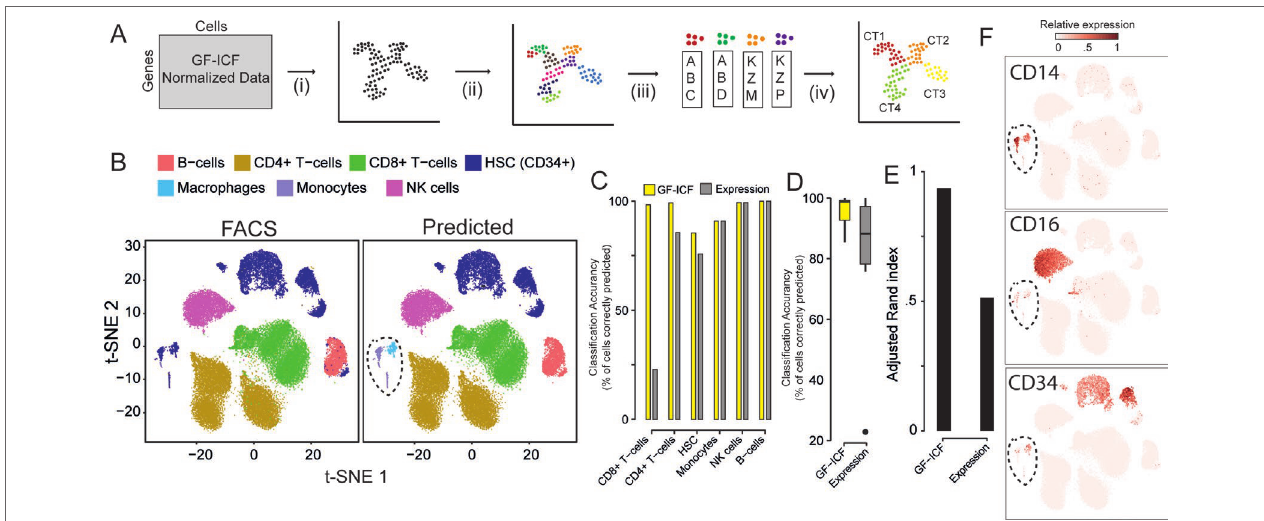
FIGURE 2 | Relevant genes extracted from the gf-icf pipeline enable cell type prediction. (A) Pipeline for the identification of cell type using gf-icf pipeline. Single-cell transcriptional profiles are normalized by gf-icf in order to score genes in each single-cell, and then (i) cells are projected with t-SNE in a bi-dimensional space; (ii) cells are divided in small groups using Louvain–Jaccard clustering; and (iii) the gene signature of each cluster is identified and (iv) used to predict cell type of origin by gene set enrichment analysis (GSEA) against a set bulk transcriptomic data of pure cell types. (B) Comparison between FACS-sorted cell type (left) and predicted cell type (right) of about 40k PBMCs. (C) Cell type prediction accuracy as a percentage of correctly predicted cells using either gf-icf or normalized counts. (D) Distribution of cell type prediction accuracy using either gf-icf or normalized counts. (E) Adjusted Rand index of cell type prediction using either gf-icf or normalized counts. (F) Expression of CD14, CD16, and CD34 marker genes for a small subpopulation of HSCs predicted instead to be monocyte and